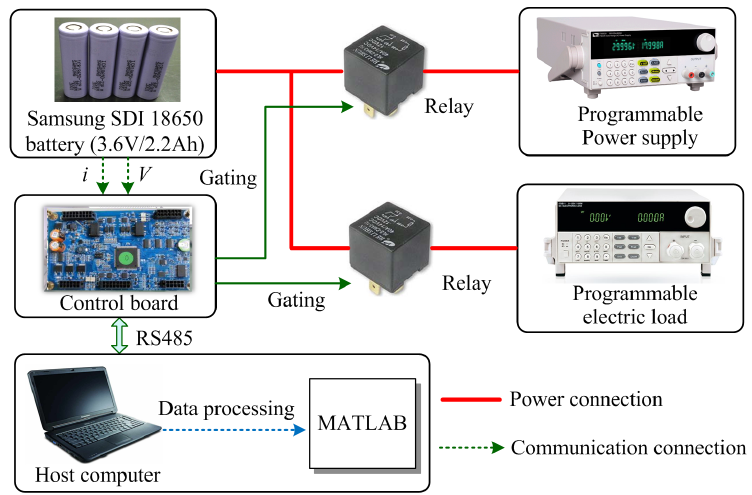
Figure 1. Configuration of the battery test